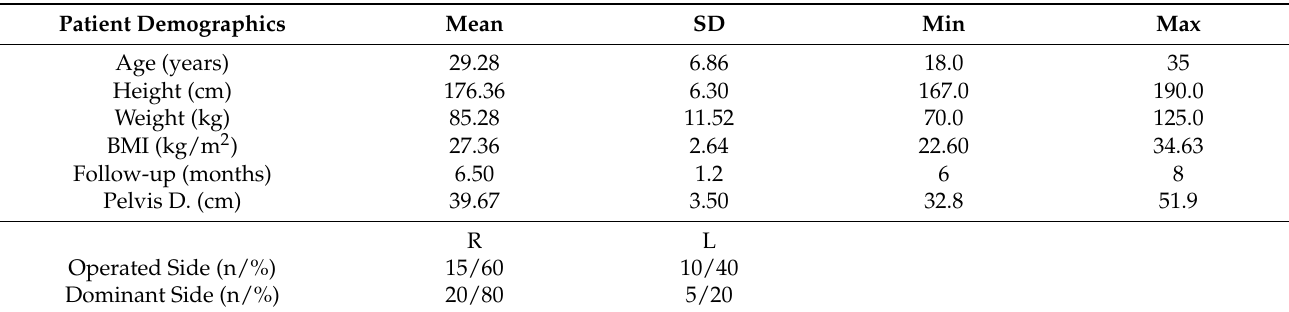
Table 1. Descriptive data of the subjects (n =